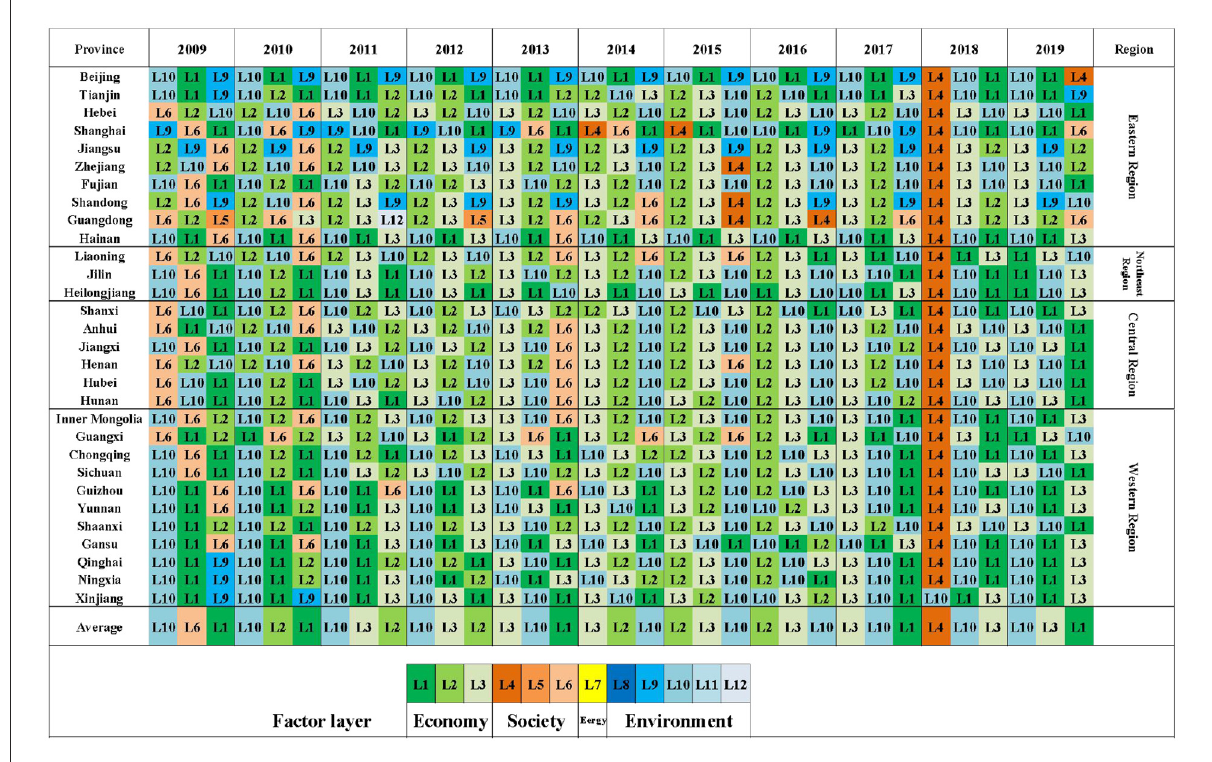
FIGURE10 Top three obstacle indexes of LCD subsystem in different regions,